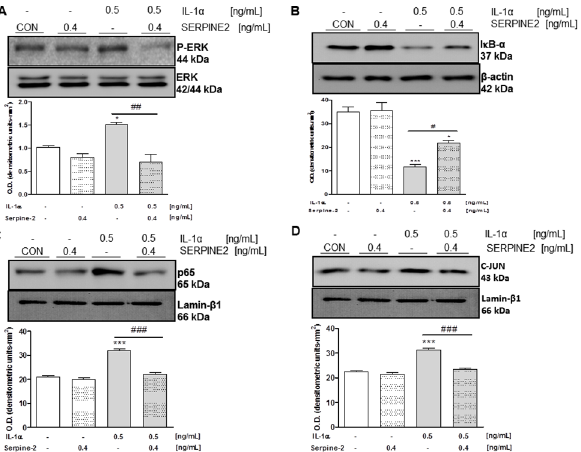
Fig 4. A. Analysis of ERK1/2 phosphorylation by western blot using lysates obtained from T/C-28a2 chondrogenic cells pretreated with SERPINE2 (0.4 ng/mL) for 12 h and then challenged with IL-1 α (0.5 ng/mL) for 30 min. Total ERK was used to ensure equal sample loading. B. I κ B- α protein expression determined by western blot using lysates obtained from T/C-28a2 chondrogenic cells pretreated with SERPINE2 (0.4 ng/mL) for 12 h and then challenged with IL-1 α (0.5 ng/mL) for 15 min. β -actin was used to ensure equal sample loading. C, D. p65 and c-Jun expression determined by western blot using nuclear extract obtained from T/C-28a2 chondrogenic cells pretreated with SERPINE2 (0.4 ng/mL) for 12 h and then challenged with IL-1 α (0.5 ng/mL) for 30 min. LaminB1 was used to ensure equal sample loading. Low panels. Densitometric analysis of at least three independent experiments. * P < 0.05 and *** P < 0.001 vs untreated control cells; # P < 0.05, ## P < 0.01 and ### P < 0.001 vs IL-1 α -stimulated